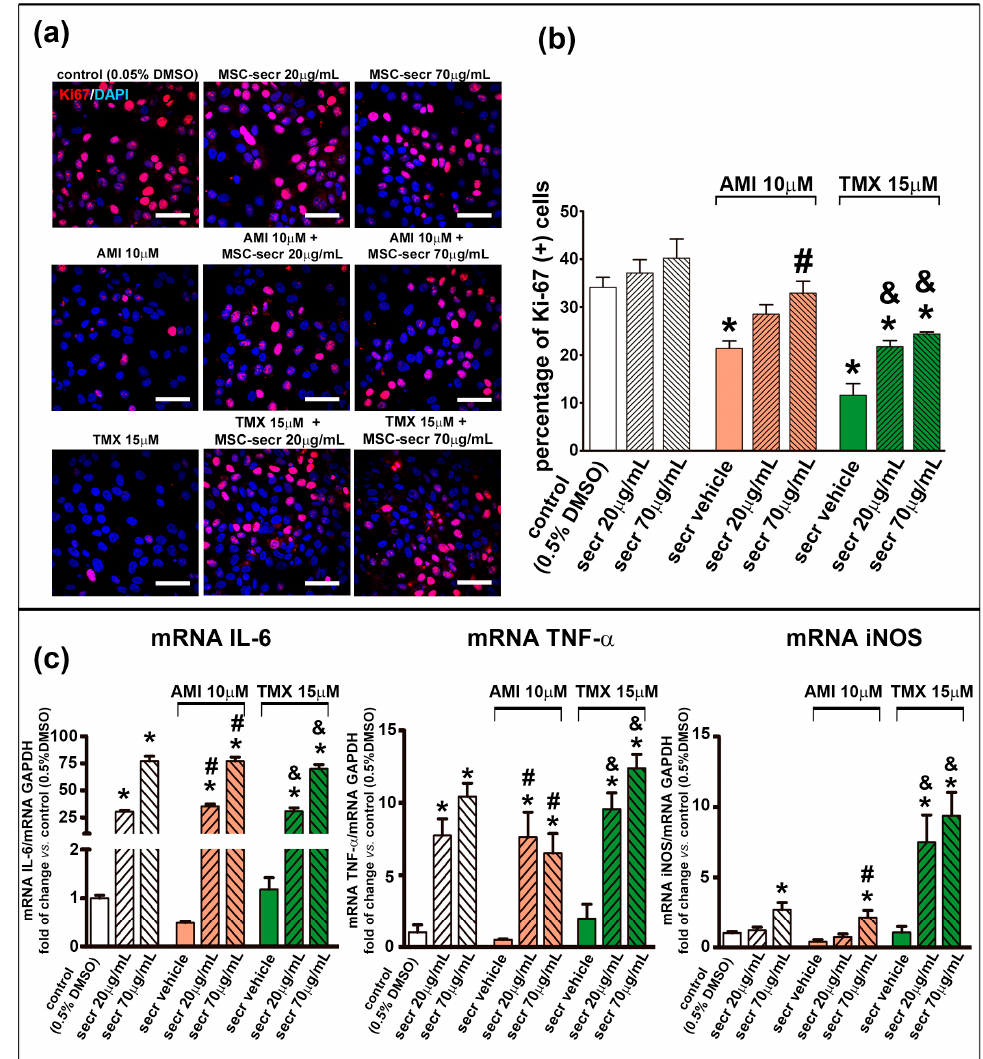
Figure 6. Coincubation with MSC secretome enhanced HepaRG proliferation after exposure to AMI or TMX. Cell proliferation was evaluated in HepRG cells exposed to AMI (red bars) or TMX (green bars) alone or coincubated with two concentrations of MSC secretome (20 and 70 µ g/mL—line pattern bars) for 24 h. As a control group, cells were incubated with the drug solvent (0.5% DMSO—white bars). Ki-67 immunoreactivity (Alexa Fluor 555, red) was evaluated by immunofluorescence. Nuclei were counterstained with DAPI (blue). The proliferation rate decreased in the HepaRG cells, when were exposed to AMI or TMX. However, coincubation with MSC secretome stimulated the proliferation of the cells in both conditions (AMI and TMX exposure). ( a ) Representative micrographs of HepaRG cells. Scale bars represent 50 µ m. ( b ) Quantification of Ki-67-positive nuclei was carried out by digital image analysis. All data are presented as means ± SEM of Ki-67-positive nuclei per 100 hepatocytes in 20 high-power fields per slides and three replicates per experimental group. ( c ) To complement the evaluation, the expression of key factors in the proliferative response after 24 h of treatment, was evaluated by RT-qPCR, normalized against GAPDH, and expressed as fold of change vs. control group (0.5% DMSO). In line with the proliferation rate, the mRNA levels of IL-6, TNF- α and iNOS were increased in the groups incubated with MSC secretome. Data are presented as means ± SEM ( n = 4) of three independent experiments. * p < 0.05 vs. control group (0.5% DMSO); # p < 0.05 vs. AMI plus secretome vehicle, of the same experimental group (same AMI concentration); & p < 0.05 vs. TMX plus secretome vehicle, of the same experimental group (same TMX concentration).